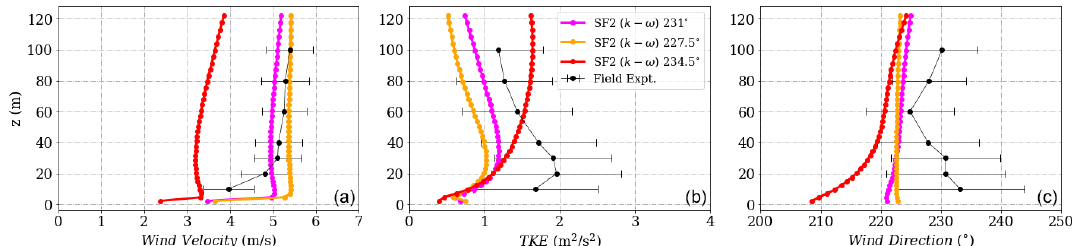
Figure D3. (a) Wind velocity magnitude, (b) Wind direction and (c) Turbulent kinetic energy at Tower 29 (tse13) for the SF2 ( k − ω ) model.